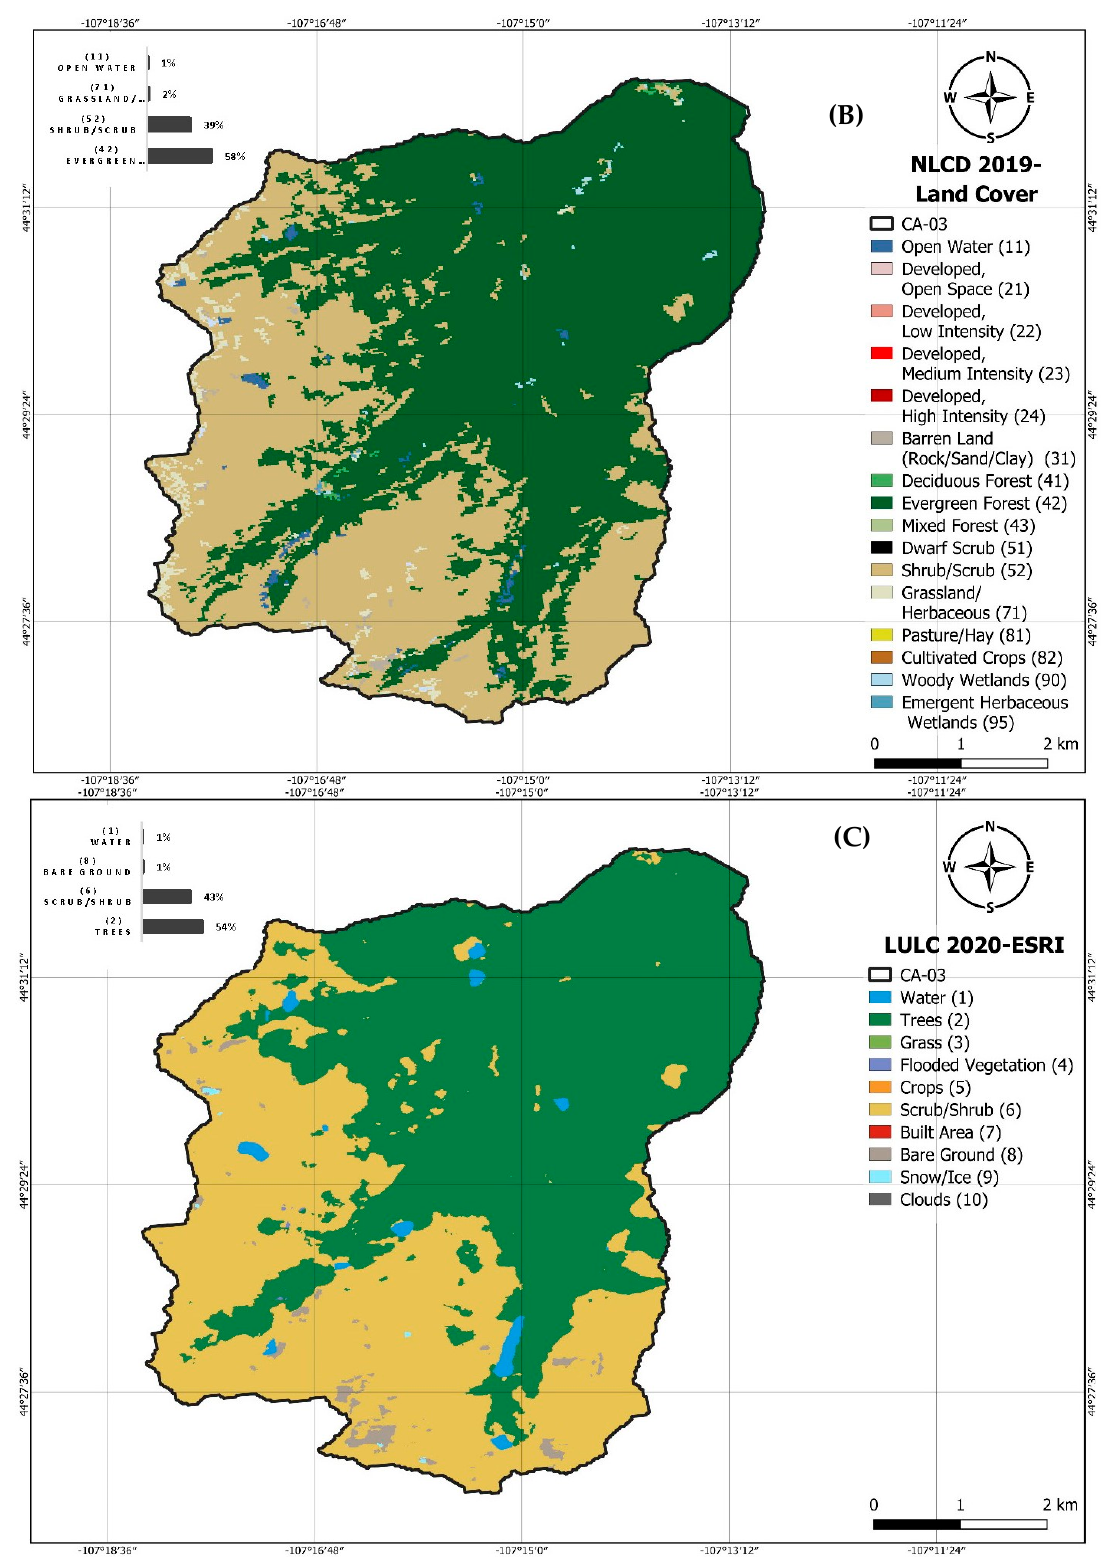
Figure A3. DEM and land-use maps for Catchment CA-03 ( A ) DEM, ( B ) NLCD 2019 land-use map, ( C ) LULC 2020-ESRI land-use map.